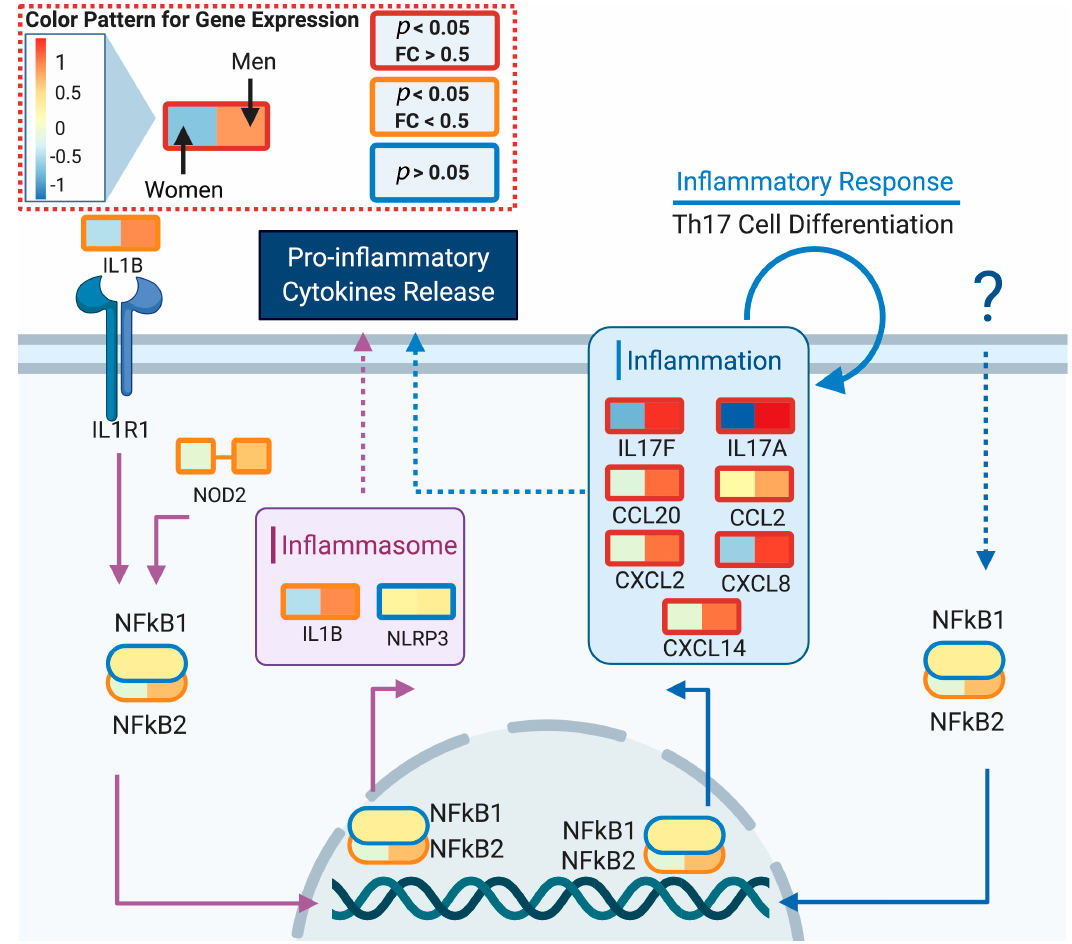
Figure 6. Differential expression of spleen cytokine and chemokine genes between sex groups. Boxes represent the mean gene expression value for old women ( left ) and men ( right ) groups at spleen samples. Old is defined as >60 years old. Box line color indicates the significance level, red: p < 0.05 and fold change (FC) > 0.5; orange: p < 0.05 and FC > 0.5 and blue: p > 0.05 (not significant). The model indicates that males have higher basal levels of proinflammatory cytokines. Created with